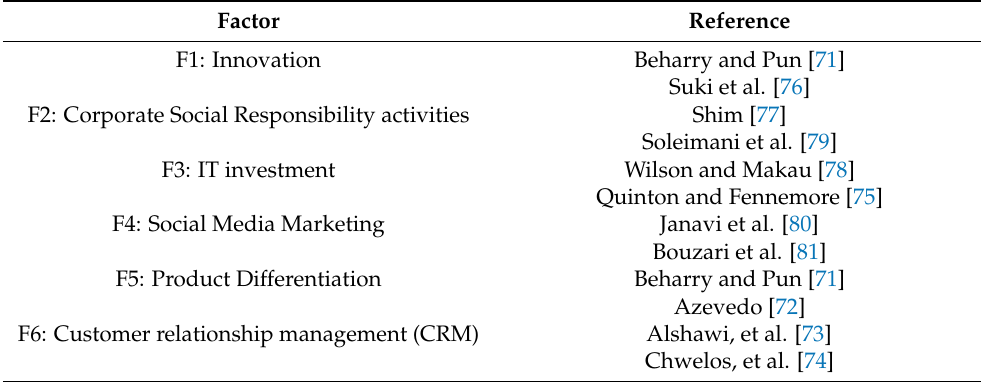
Table 1. Factors affecting resource, budget allocation, and